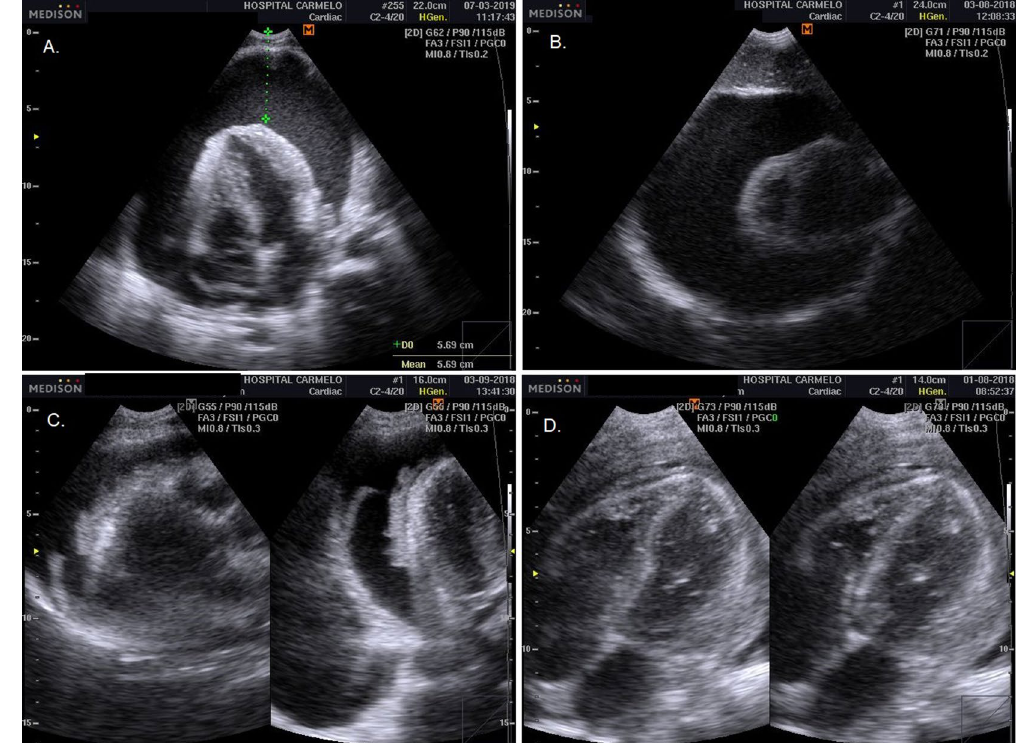
Figure 4. Pericardial TB: pericardial effusions with fibrinous filaments ( A , B ); and pericardial thickening ( C , D ) with complications, such as cardiac tamponade or impaired diastolic function, indicating pericardial